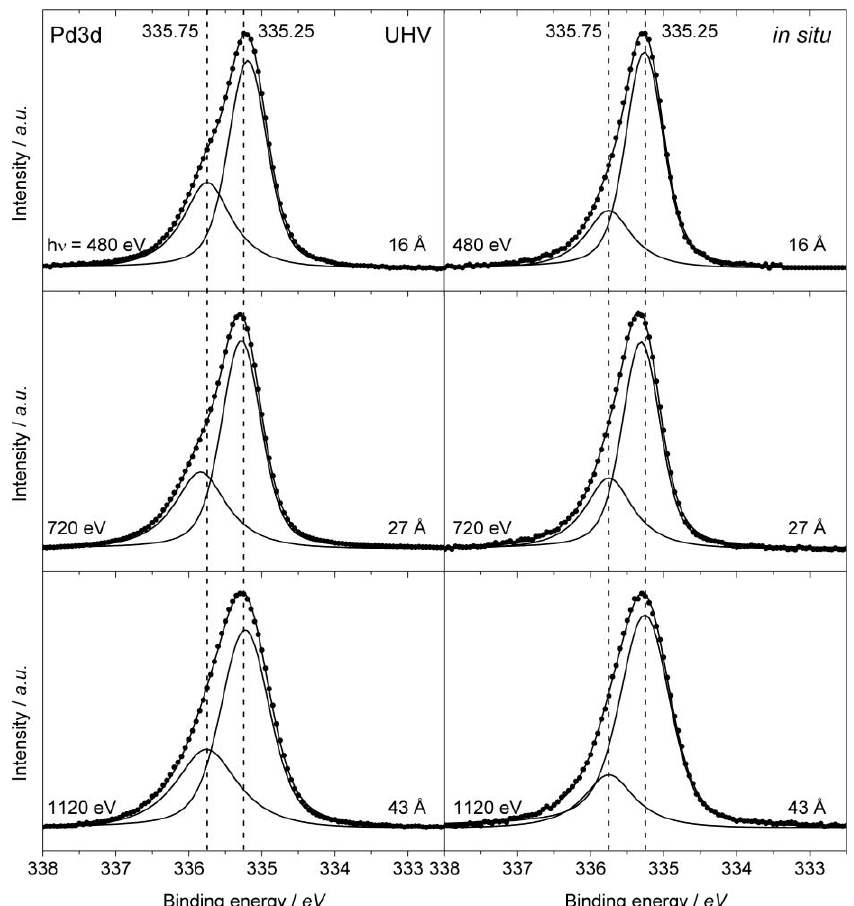
Figure 10. XPS Pd3d core level of ordered Cu 10 −8 mbar) and under in situ conditions (120 °C, 0.1 mbar C respective photon energies and information depths are